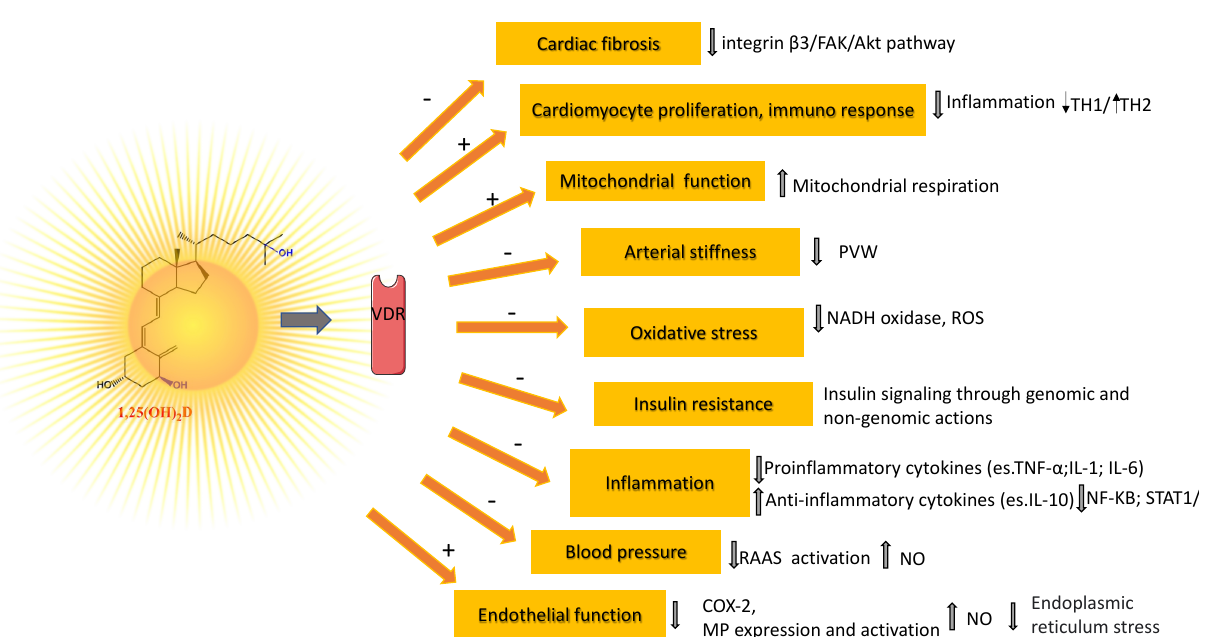
Figure 1. Main Vitamin D mechanisms of actions related to oxidative stress and inflammatory processes and vascular health. ↑ increase, ↓